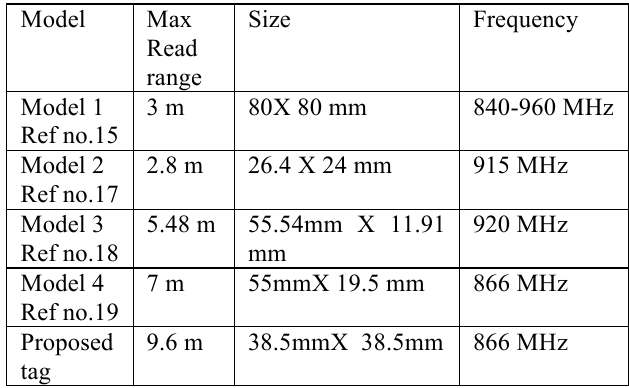
Figure 5: Measured read range differences with frequency for the projected RFID tag at bore-sight with θ =0 o , ϕ =0 o Variation of the measured read range with azimuth angle is plotted in figure 6b. The maximum reading range is 9.6 meters with limited angular ranges and then decreases rapidly on either side of the bore sight reaching a minimum of 4.5 meters at 90 o . However the proposed tag functioning in complete UHF RFID band and shows good read range features above the elevation and azimuth angular ranges.